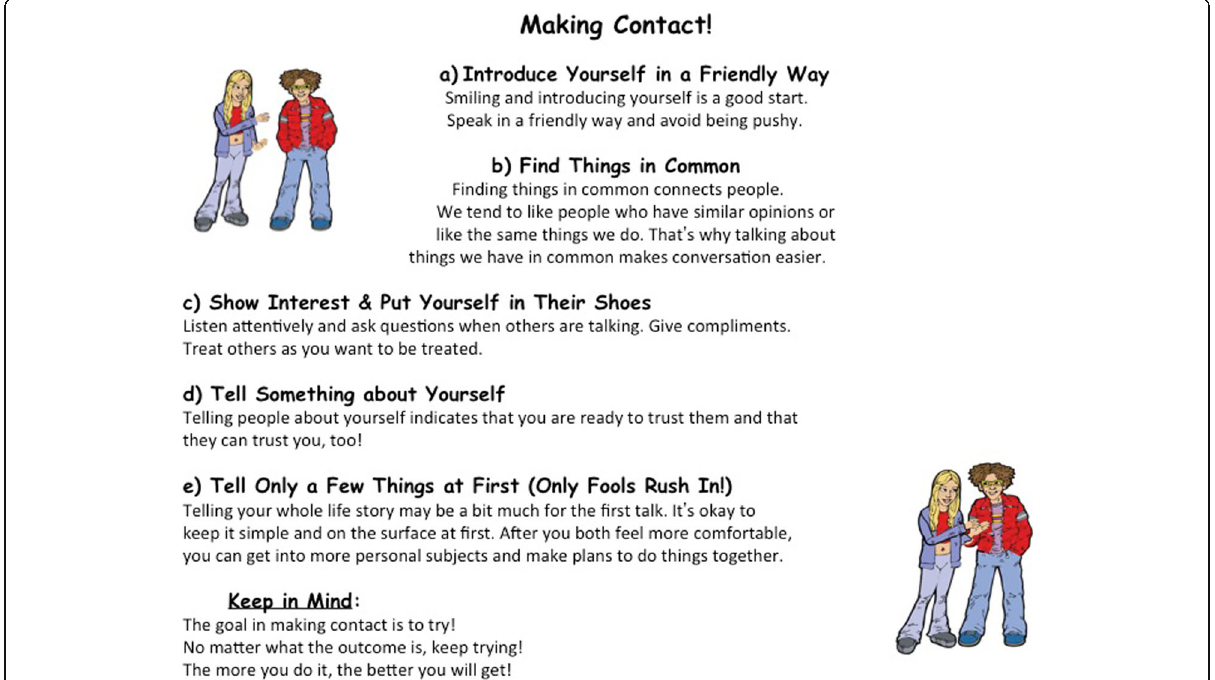
Fig. 11 List of steps how to appropriately make contact with